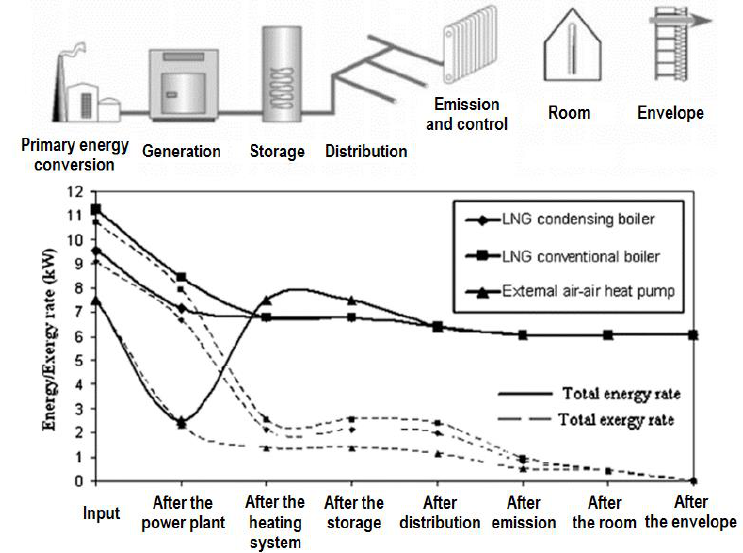
Figure 3. Energy and exergy flow rates through the system components [19].